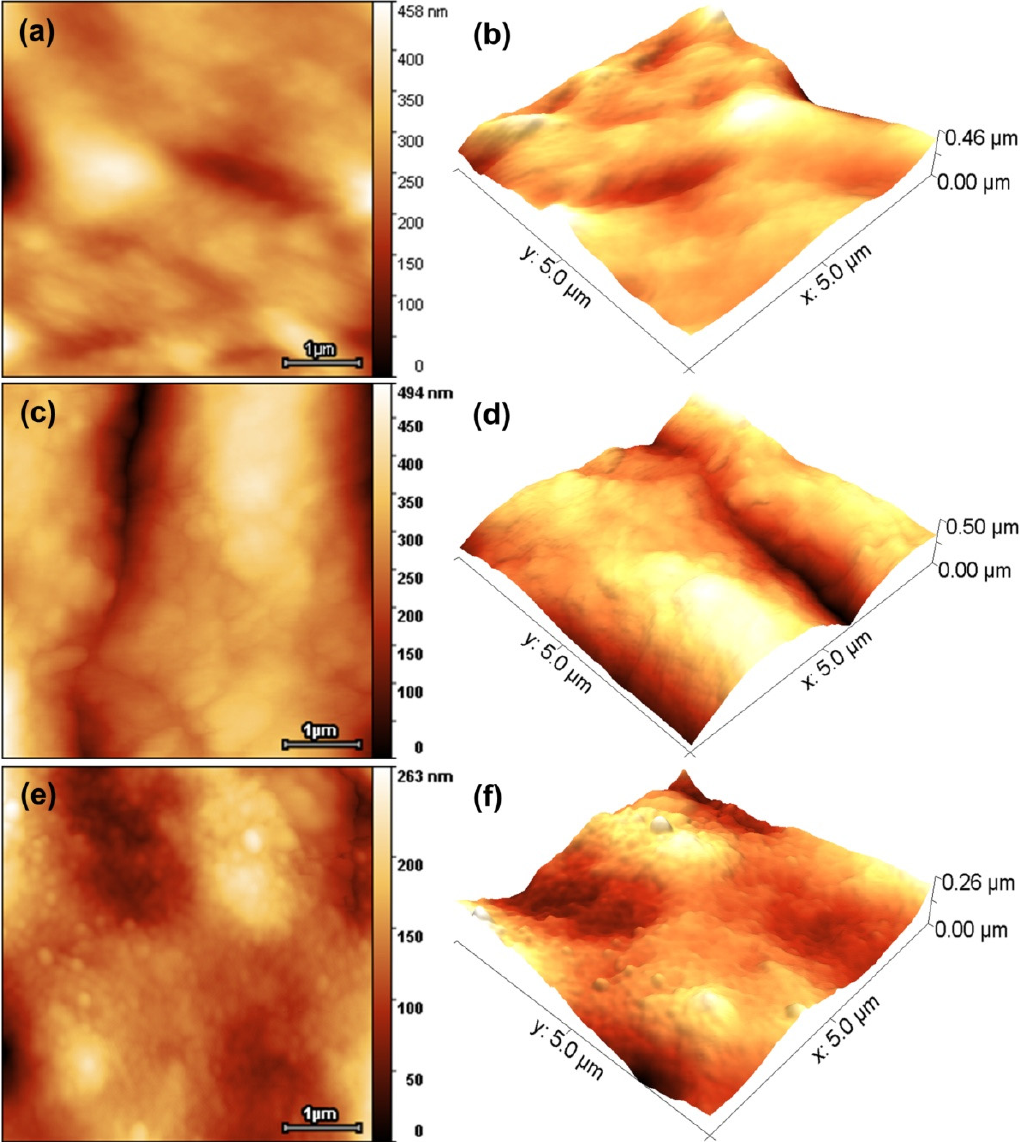
Figure 3. AFM relevant images of the untreated and treated TPS thin films: ( a , b ) untreated, ( c , d ) HDMSO-treated, and ( e , f ) He/HDMSO-treated.